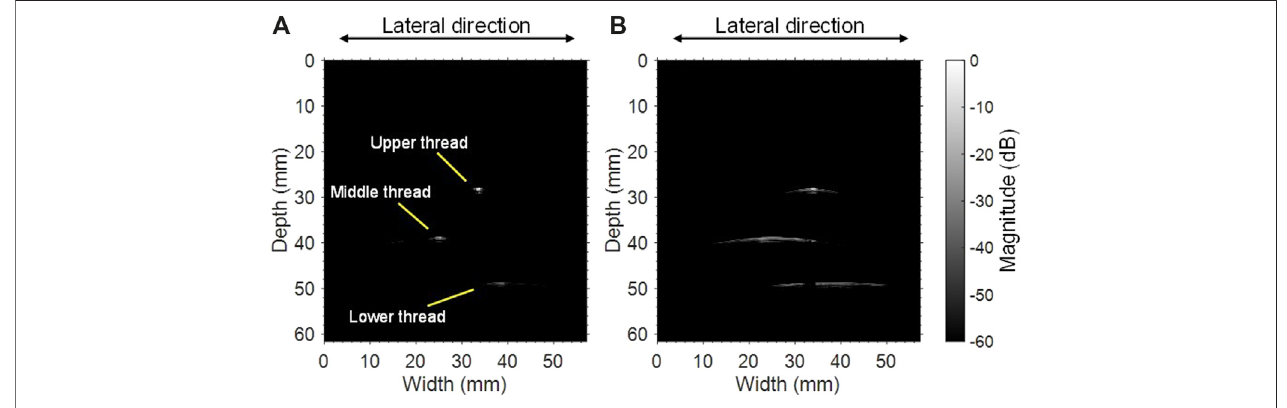
FIGURE4| B-modeimagesofthreenylonthreadsobtainedusing (A) theproposedmethodand (B) theconventionalapproachwithoutcurvedsurfaceinformation.